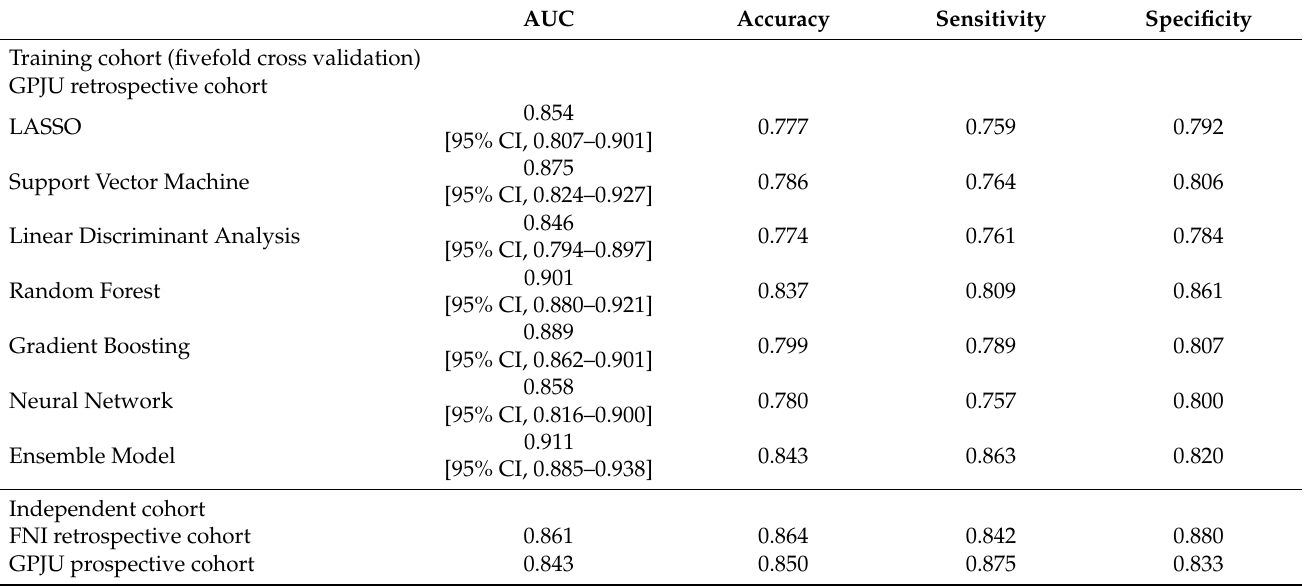
(Table 3). The true-positive, true-negative, false-positive, and false-negative predictions in the training and independent validation cohorts are listed in Figure 3. Most cases can be correctly classified. Table 3. Model performance using different algorithms. AUC Accuracy Sensitivity Specificity